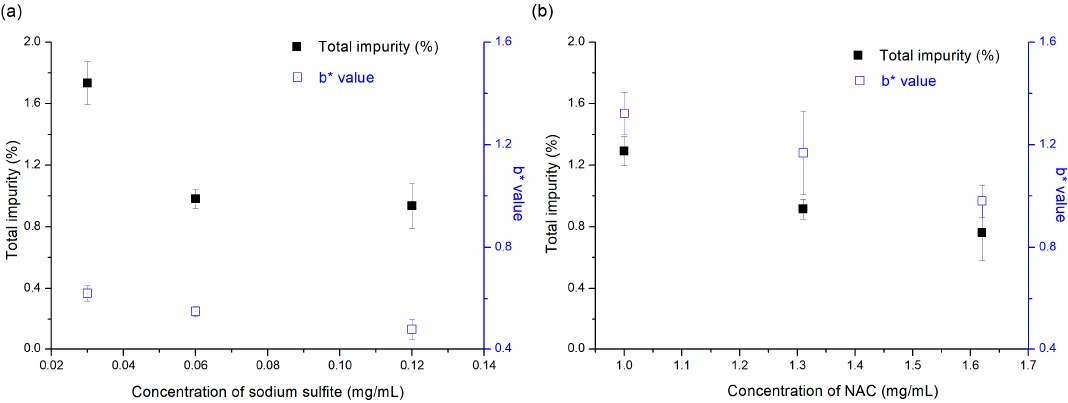
Figure 3. E ff ect of antioxidant concentration on the total impurity ( (cid:4) ) and color change ( (cid:3) ) Figure 3. Effect of antioxidant concentration on the total impurity ( ■ ) and color change ( □ ) generated